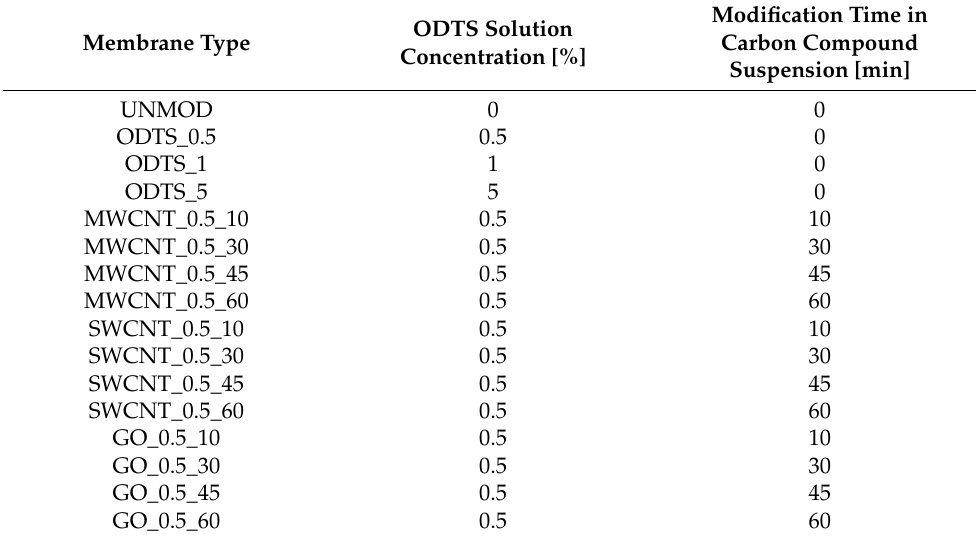
Table 1. Modification process parameters of the test membranes in the stationary system. Membrane Type